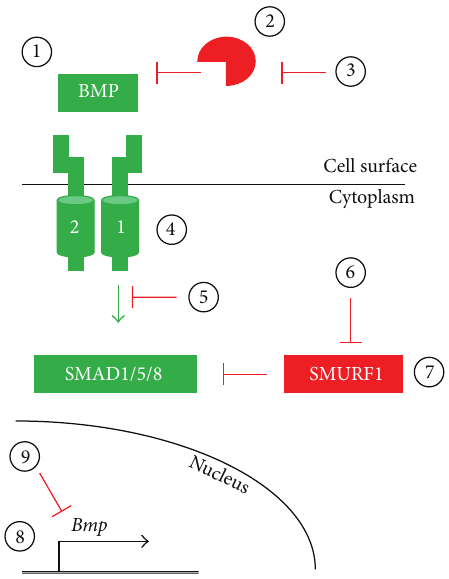
Figure 1: Potential strategies for modulating the BMP pathway. (1– 3) The BMP pathway may be activated by exogenous natural or engineered BMP ligands or by expression of such ligands via gene transfer techniques (1). Ligand-induced BMP pathway activation may be inhibited by extracellular ligand traps, such as naturally- occurring antagonists or neutralizing antibodies, via delivery of recombinant protein or expression via gene transfer techniques (2). Endogenous extracellular BMP antagonists, such as Noggin or Chordin, may be inhibited via neutralizing antibodies or small molecules, resulting in increased BMP signaling (3). (4-5) The endogenous BMP pathway inhibitors FKBP12 and Casein Kinase 2 may be inactivated by delivery of FK506 and CK2.3, respectively, thereby increasing signal transduction (4). Alternatively, BMP receptor-mediated activation of the SMAD effectors may be blocked by kinase inhibitors (5). (6-7) Persistence of BMP signaling may be modulated by regulating the SMURF1-mediated ubiquitination of SMAD effector proteins by disrupting SMURF1 interaction with SMADs by small molecule inhibitors (6) or by increasing SMURF1 protein levels (7). (8-9) BMP pathway component expression may be elevated by increasing transcription or alleviating microRNA- mediated translational silencing (8). Alternatively, BMP pathway component levels may be reduced by reducing transcription and/or translation rates